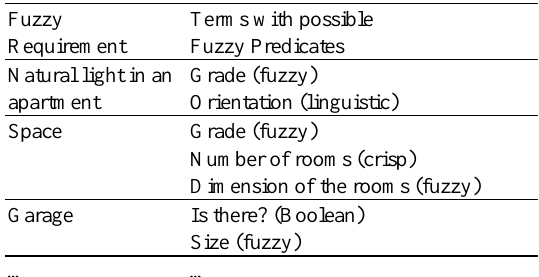
Table 1: Fuzzy Requirements